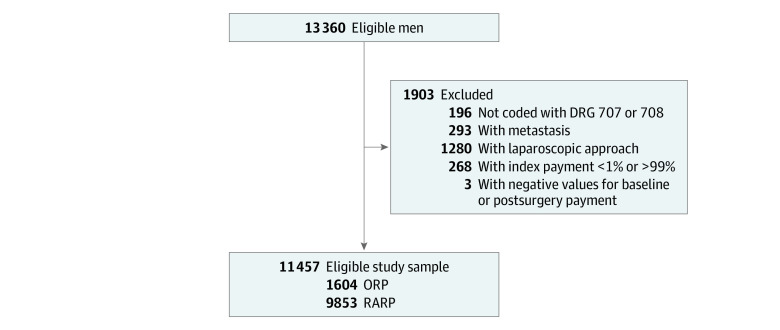
Flow Diagram of StudyDRG indicates diagnosis-related group; ORP, open radical prostatectomy; and RARP, robotic-assisted radical prostatectomy.